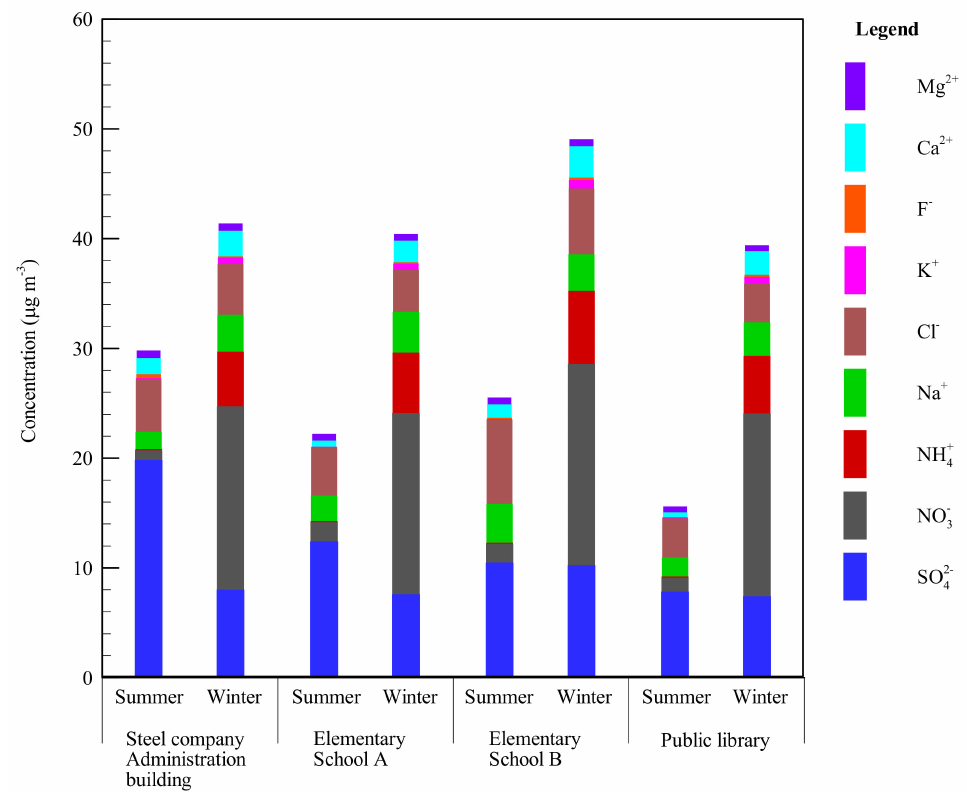
Figure 5. Percentage of water-soluble ions in TSP for winter and summer and at the steel company’s administration building, elementary school A, elementary school B, and public